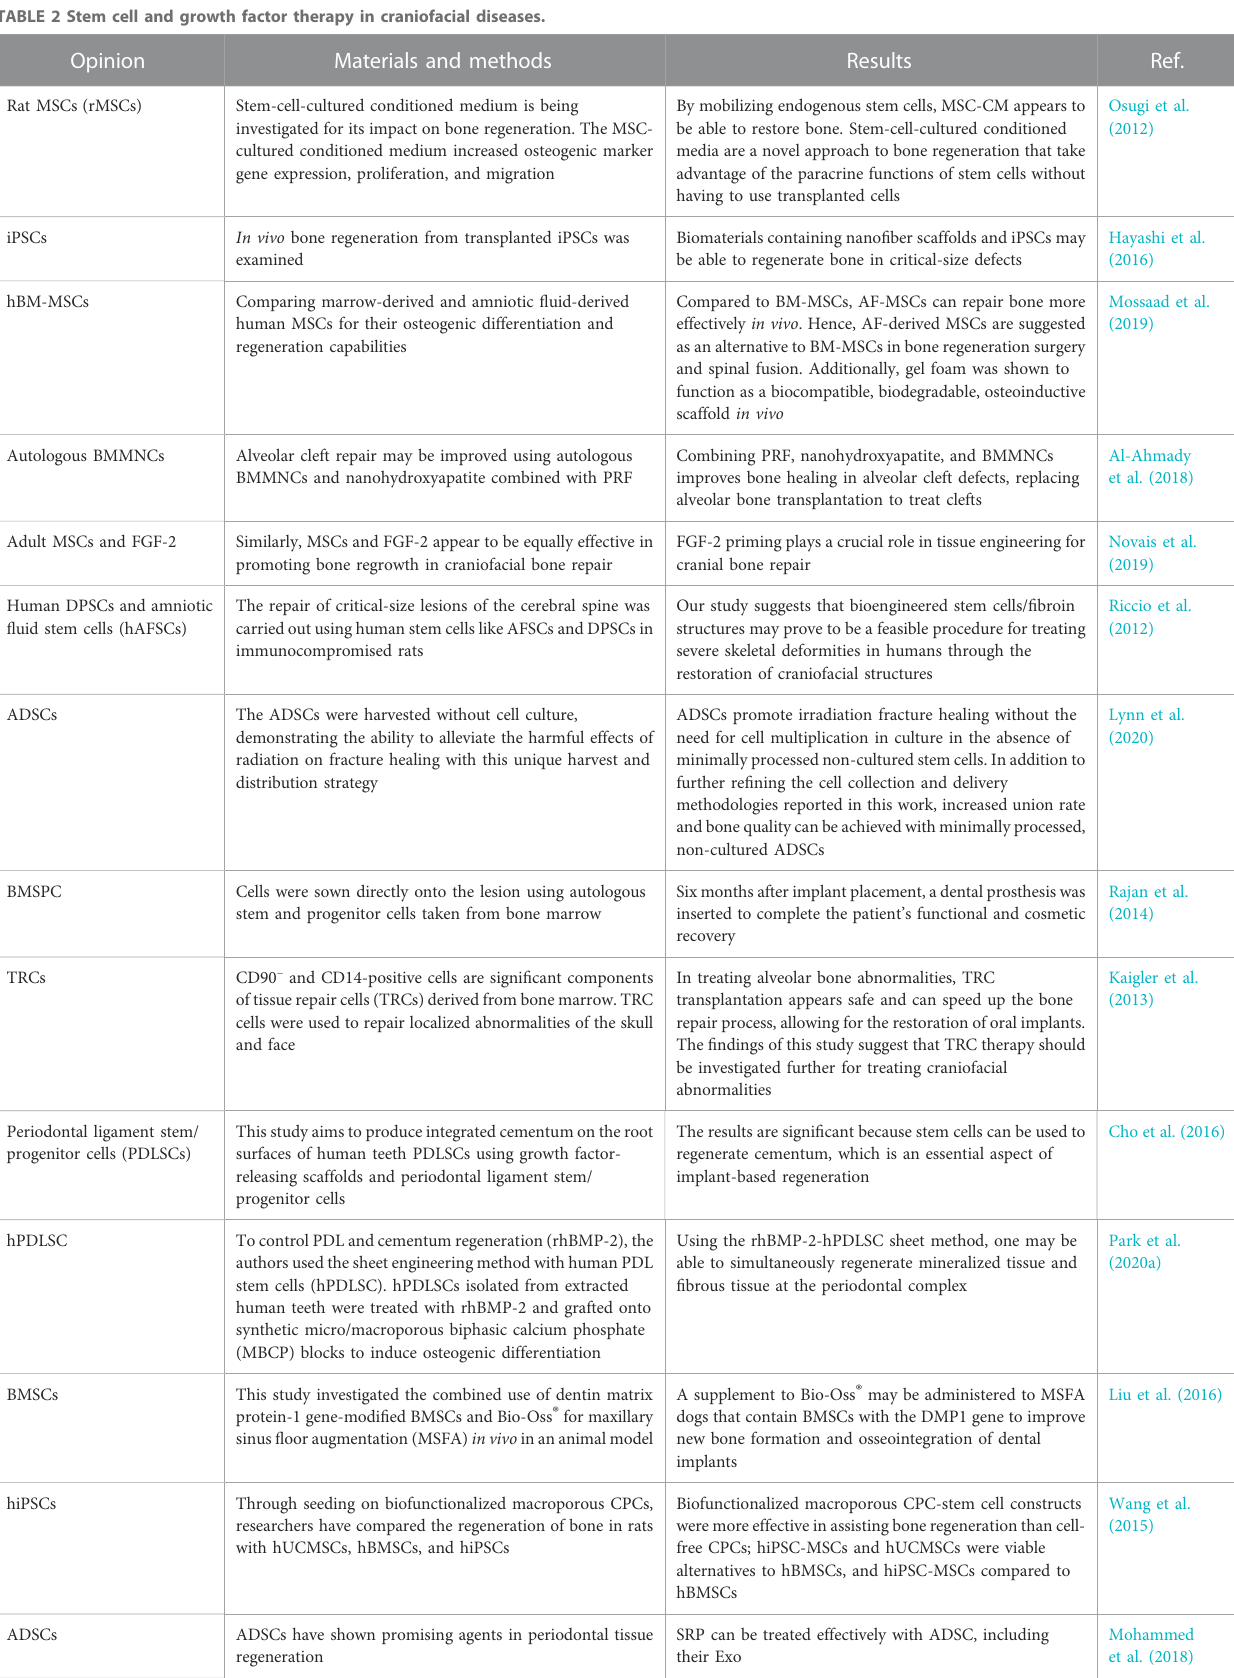
TABLE 2 Stem cell and growth factor therapy in craniofacial